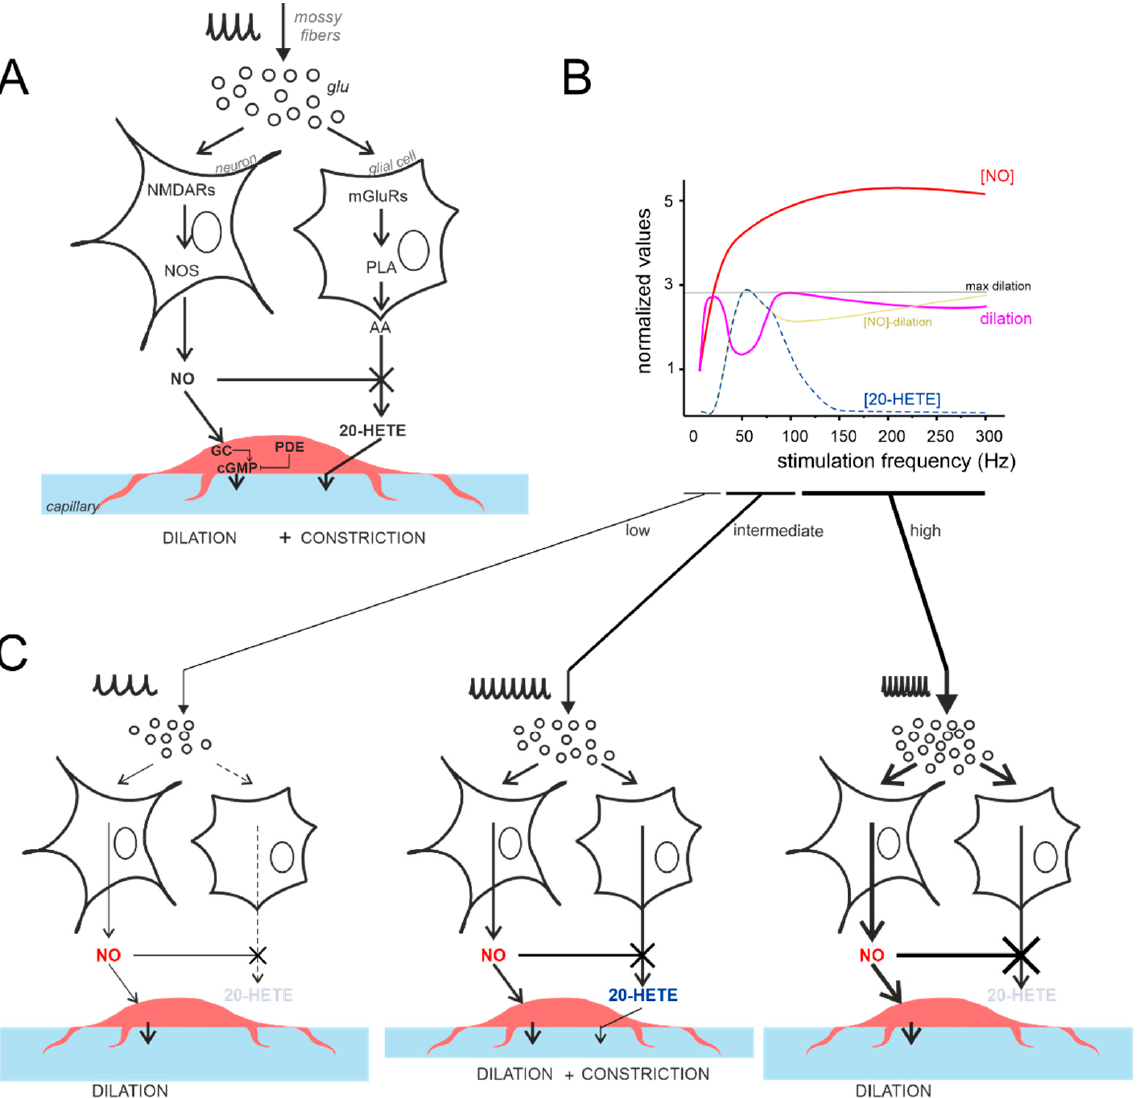
Figure 7. The vasodilation–vasoconstriction competition hypothesis. ( A ) Schematic illustration of the main players involved in NO and 20-HETE release, according to [21]. Vasodilation is mediated by the NMDAR-NOS-NO pathway, while vasoconstriction is mediated by the mGluR-PLA-20-HETE pathway. Notice that NO inhibits 20-HETE synthesis [8]. PLA, phospholipase A; GC, guanylyl cyclase; PDE, phosphodiesterase. ( B ) Schematic illustration of the competition between NO and 20-HETE in determining vessel diameter changes. [NO] (red) is directly proportional to the simulated NMDA current (not shown), while capillary dilation (violet) is provided by experimental measurements (the difference between the two curves is in yellow). The 20-HETE is specular to the NVC inflection at intermediate frequencies (more details are given in text). ( C ) The differential engagement on the NO and 20-HETE pathways are shown for low, intermediate, and high stimulus frequencies (note the different thickness of the arrows).